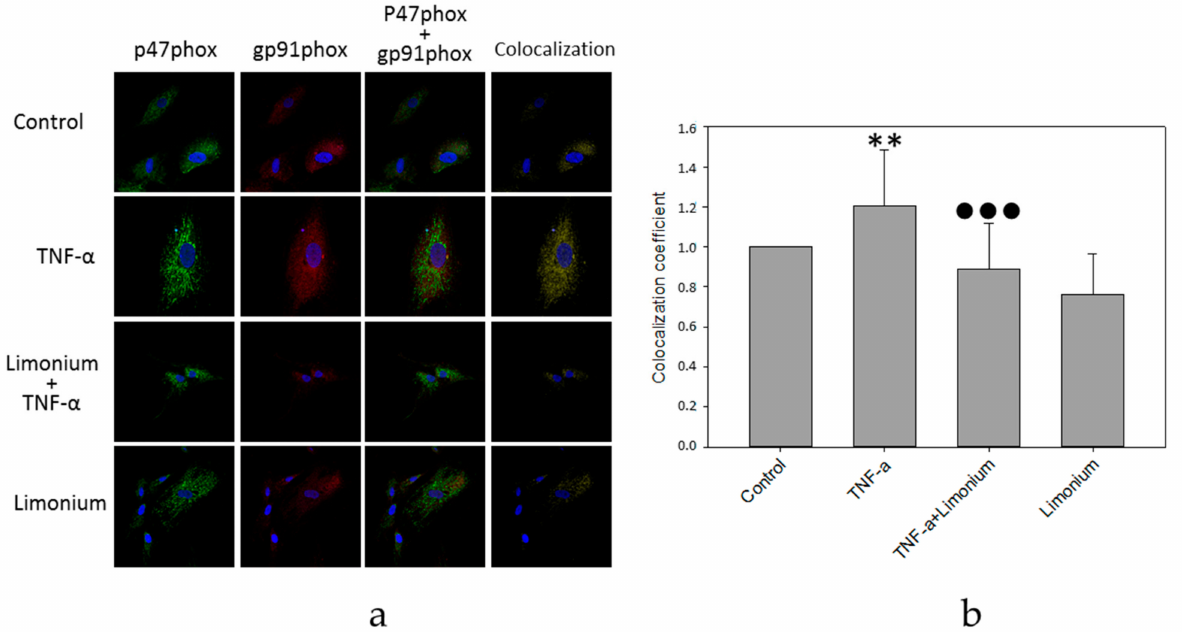
Figure 4. L. gmelinii extract suppresses activation of NADPH-oxidase induced by TNF- α in human primary astrocytes. NADPH-oxidase activity is represented by the coefficient of gp91phox and p47phox subunits co-localization (normalized to the control group). Confocal images ( a ), quantitative analysis ( b ). **— p ≤ 0.01 compared to the control; ••• — p ≤ 0.001 compared to the group treated with TNF- α